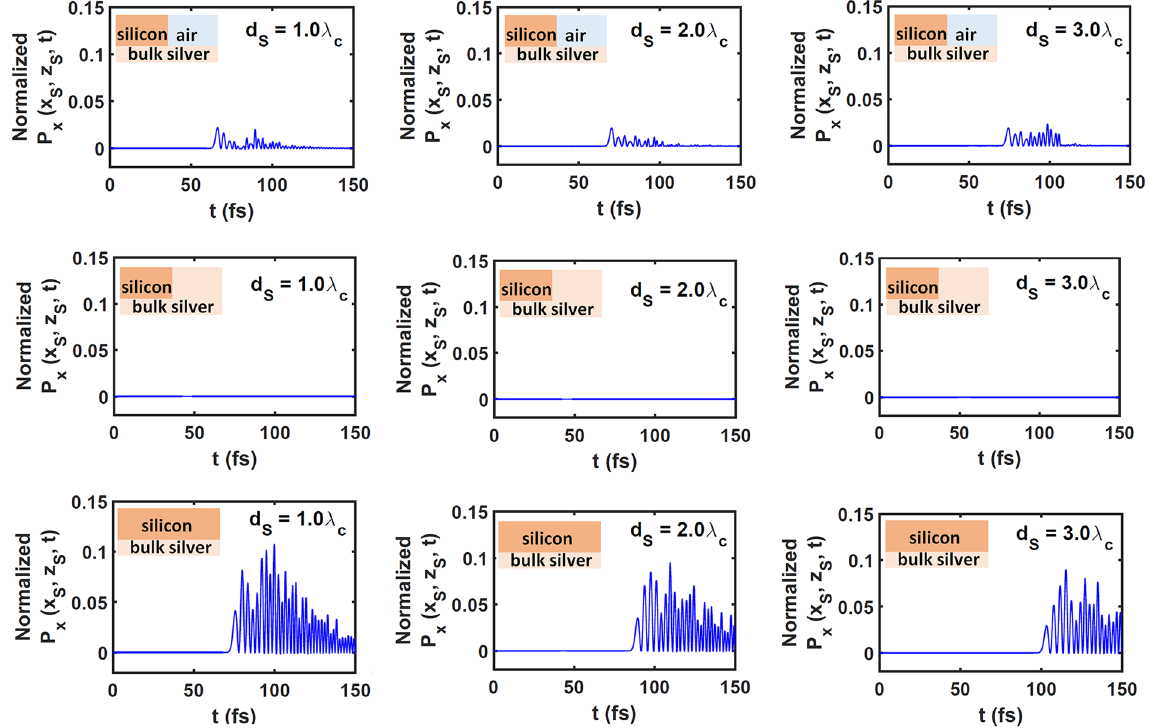
Figure 5. Temporal profile of normalized P x z t ( , , ) when λ = 1200 nm and  is occupied by silver. Top x S S c D  is occupied by silver, and bottom row:  is occupied by silicon. row:  is occupied by air, middle row: C C C λ = , and right column: λ = d / 3 Left column: λ = d / 1 , middle column: d / 2 . Each profile is of the received S c S c S c signal at point S. Multiply by 6.8 × 10 − 6 W m − 2 to obtain unnormalized P x z t ( , , ) . x S S